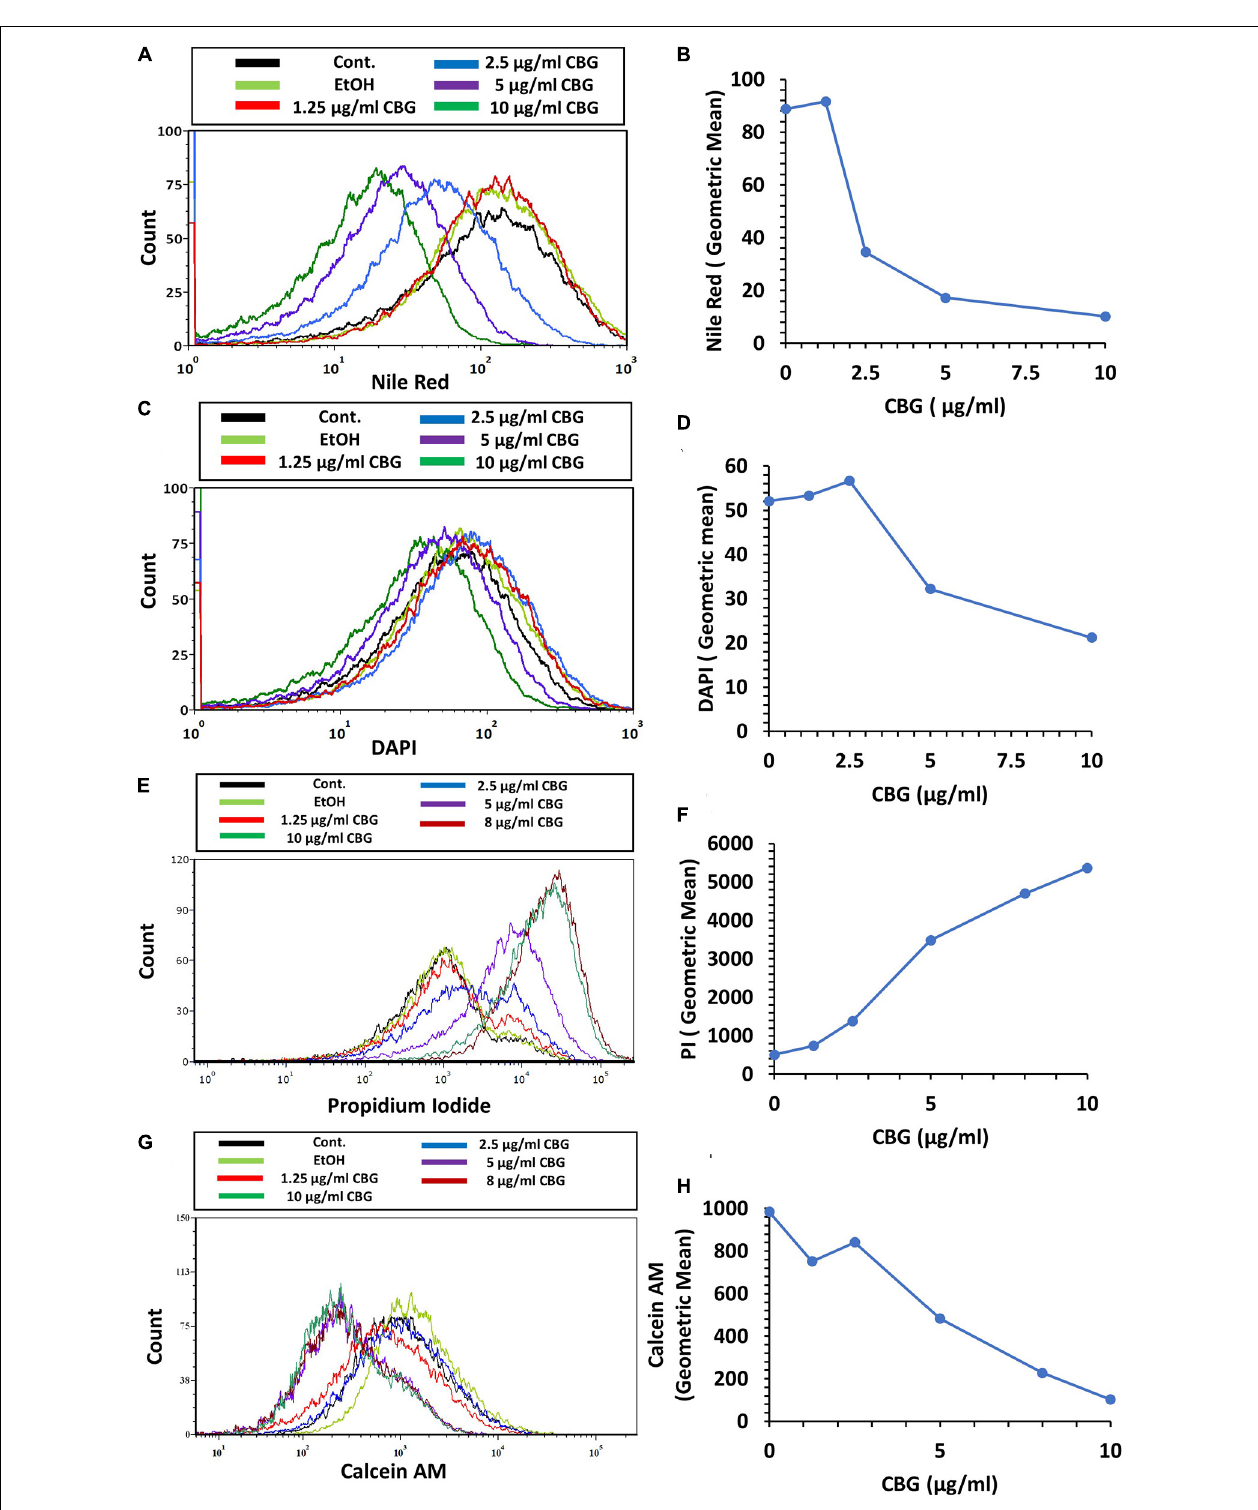
FIGURE 6 | CBG alters the membrane properties of S. mutans. (A,B) The fluorescence intensity of Nile Red membrane staining of control and 2 h CBG (0–10 µ g/ml)-treated bacteria as determined by flow cytometry. (C,D) The fluorescence intensity of DAPI staining of control and 2 h CBG (0–10 µ g/ml)-treated bacteria as determined by flow cytometry. (E,F) Flow cytometry of PI-stained S. mutans that have been treated with different CBG concentrations (0–10 µ g/ml) for 2 h. (G,H) Flow cytometry of Calcein AM-stained S. mutans that have been treated with different CBG concentrations (0–10 µ g/ml) for 2 h. (A,C,E,G) are the histograms of flow cytometry. (B,D,F,H) present the geometric mean of the flow cytometry data as a function of CBG concentration.